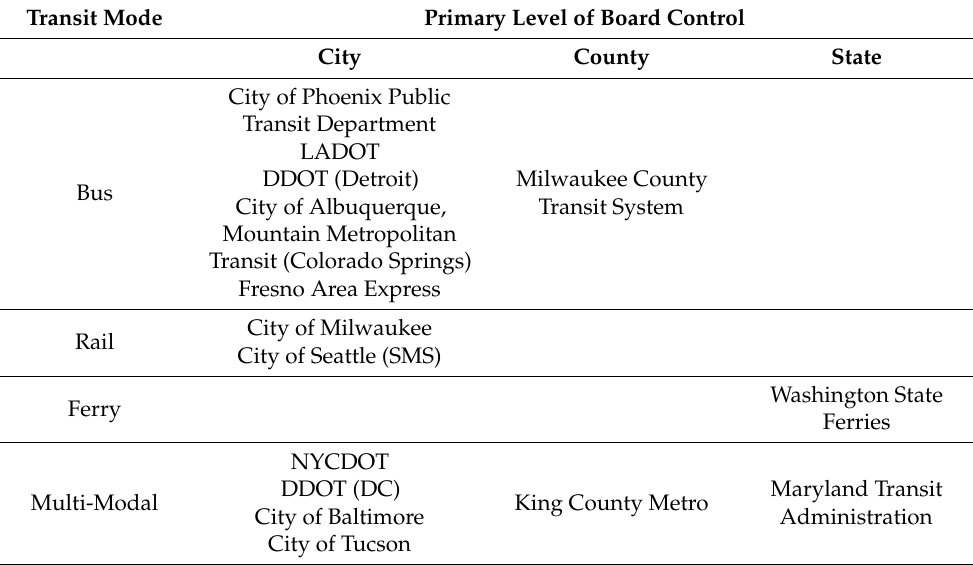
Table 4. Government Department by Level of Control and